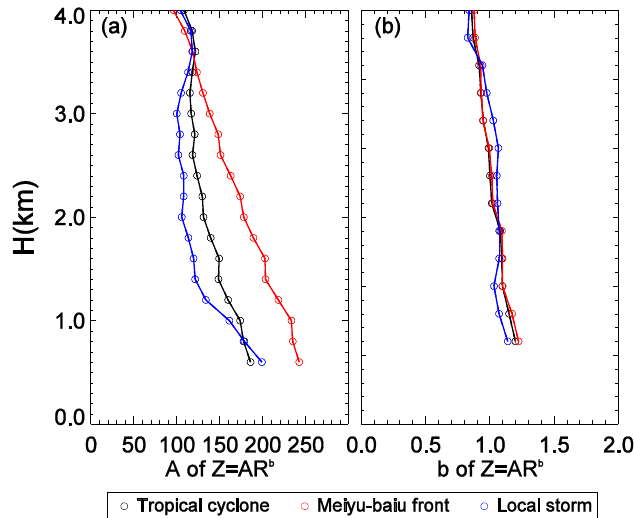
Figure 10. The vertical distributions of parameters with ( a ) coefficient A and ( b ) power b of the Z – R relationship for the three rain types based on MRR data.